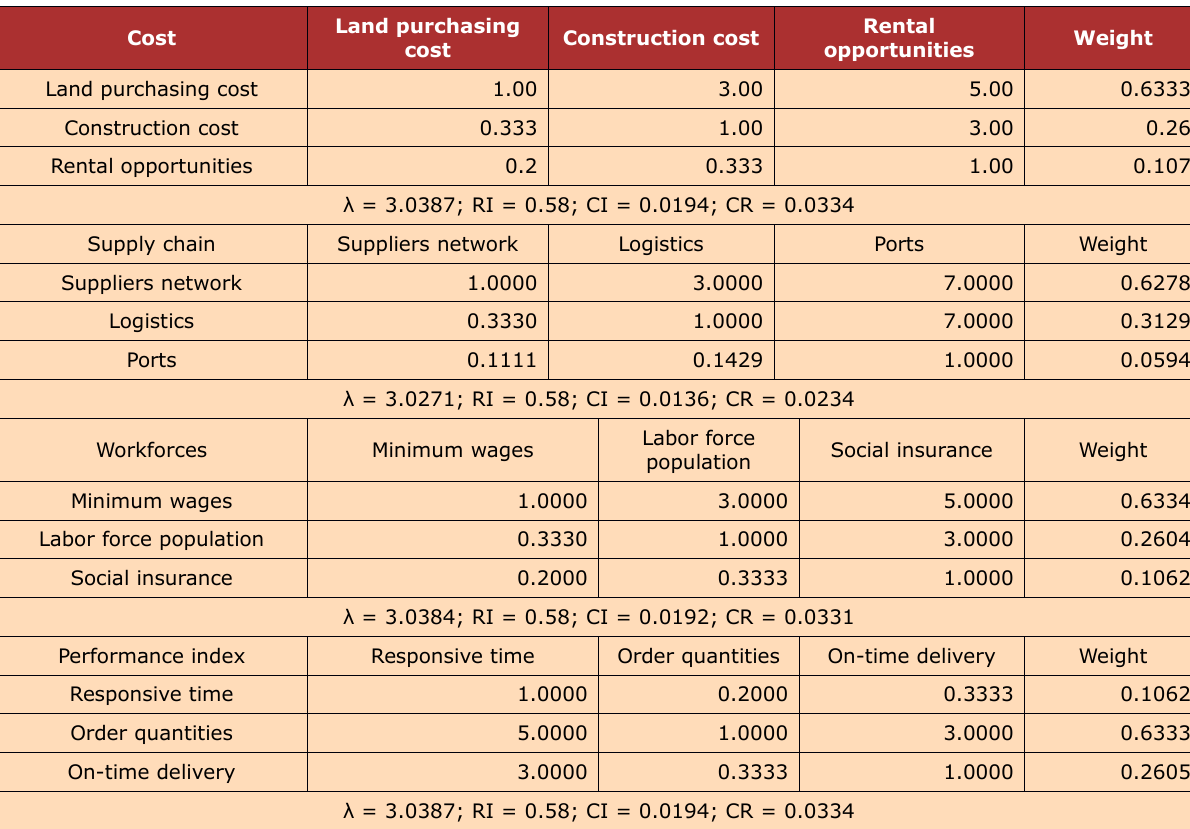
Table 9. Pair-wise comparison matrix for the subcriteria of four selected